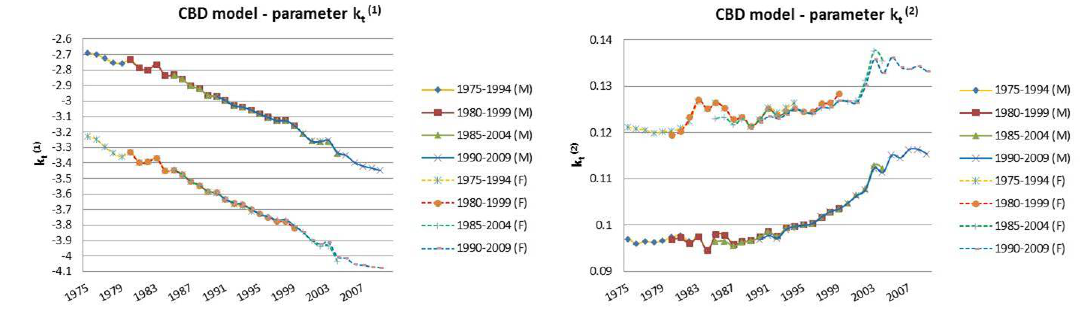
Figure 13. CBD Jumping Fixed-Length-Horizon: parameter estimates.